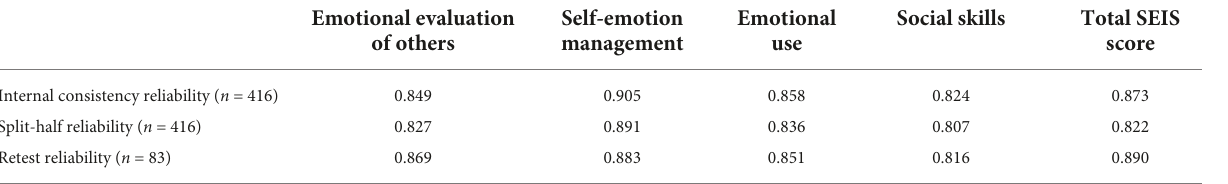
TABLE 5 Reliability analysis table of the Chinese version